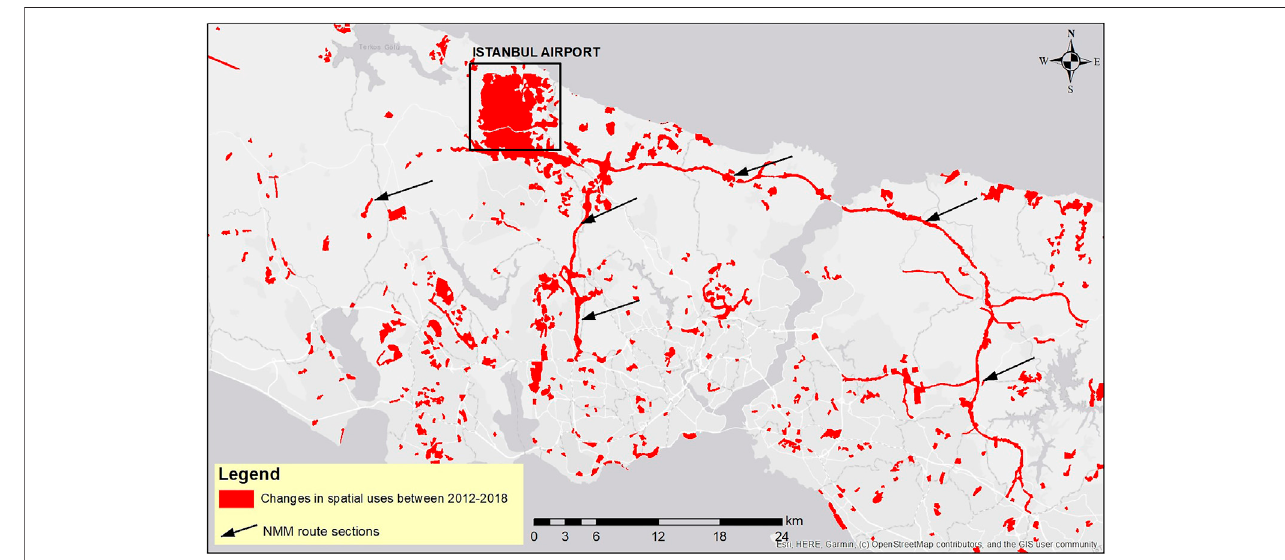
FIGURE 3 | Changes in spatial uses in 2012 – 2018